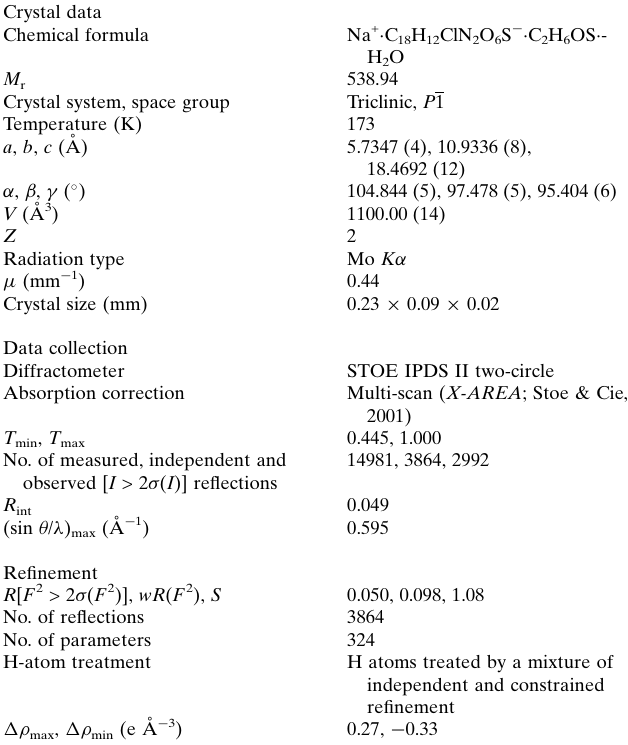
Table 3 Experimental details. Crystal data Chemical